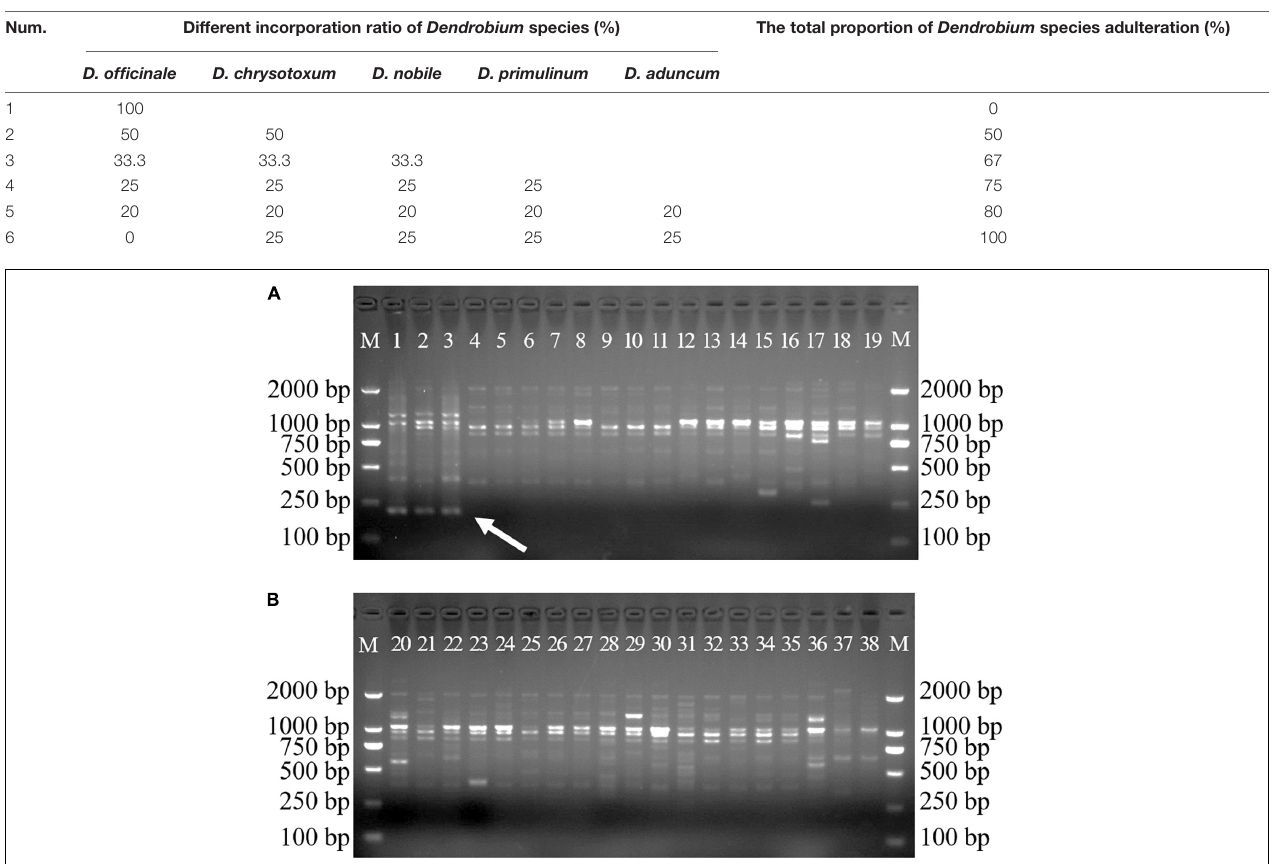
TABLE 5 | Simulated adulteration samples used for SCAR marker SHF/SHR application. Num.